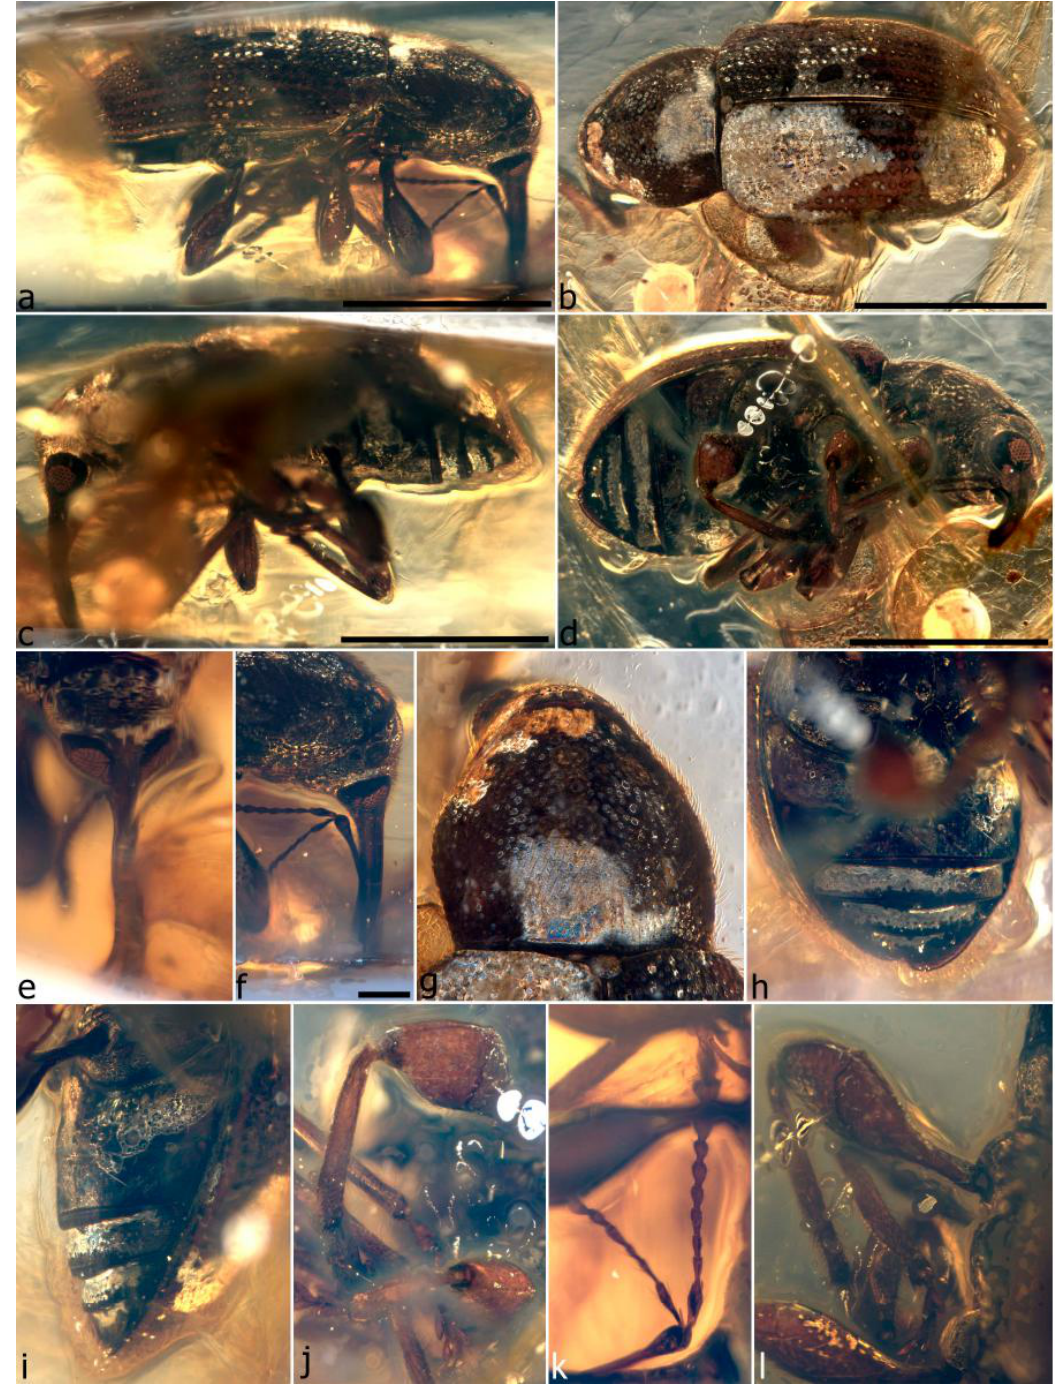
Figure 92. Aphelonyssus latus sp. n., holotype. Habitus, right lateral ( a ); habitus, dorsal ( b ); habitus, left lateral ( c ); habitus, ventral oblique ( d ); head and eyes, dorsal ( e ); prothorax and head, right lateral ( f ); pronotum, dorsal ( g ); ventrites ( h ); ventrites, left lateral ( i ); meso- and metafemora and metatibia ( j ); right antenna ( k ); right metafemur and tibia ( l ). Scale bars: 0.5 mm (a–d); 0.2 mm (f).